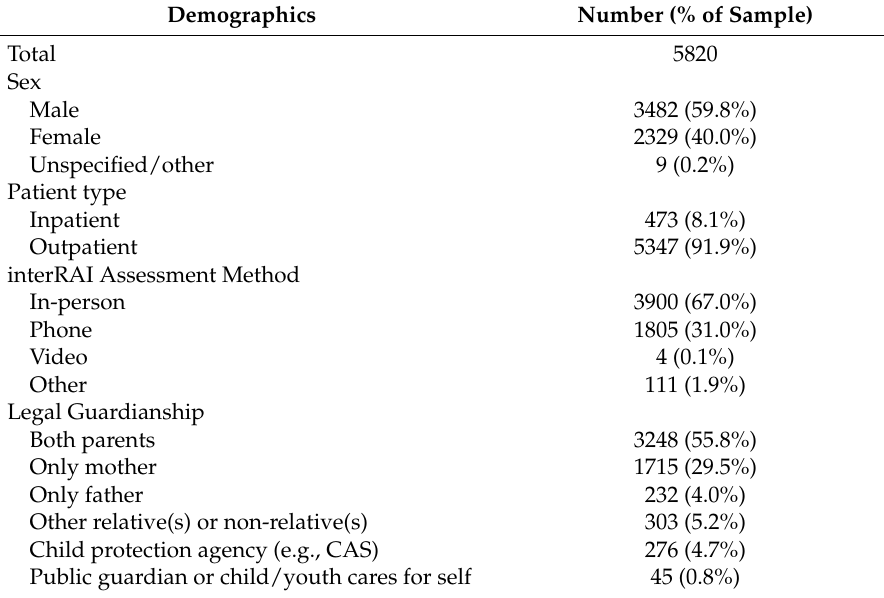
Table 1. Demographics table for children/youth ( N = 5820) assessed using the interRAI Child and Youth Mental Health